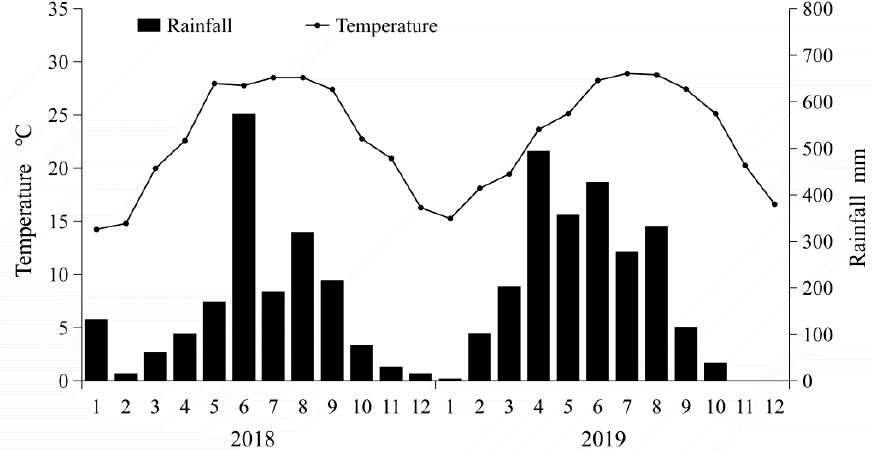
Figure 1. Rainfall and average temperature per month during the experimental years (2018, 2019). Numbers 1–12 in the X axis represent the 12 months in a year.